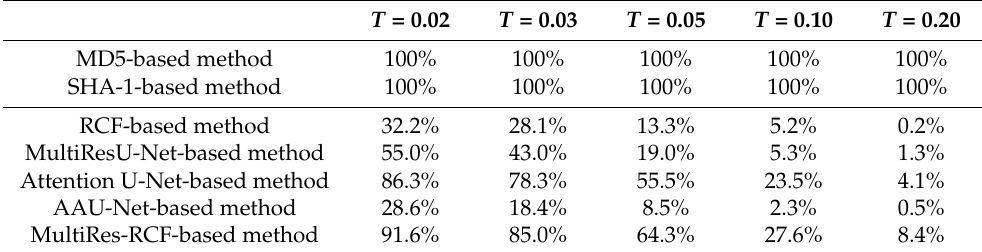
Table 8. Tamper detection rate after 16 pixels have been modified.